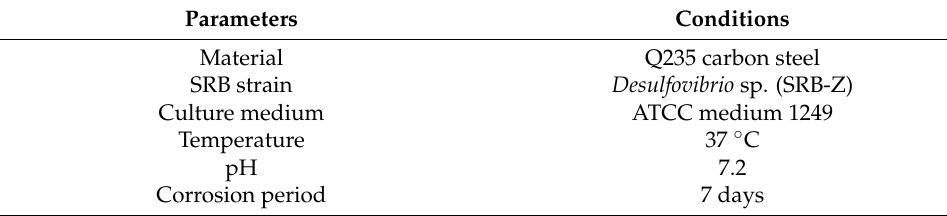
Table 2. Test matrix for the SRB-Z influenced corrosion